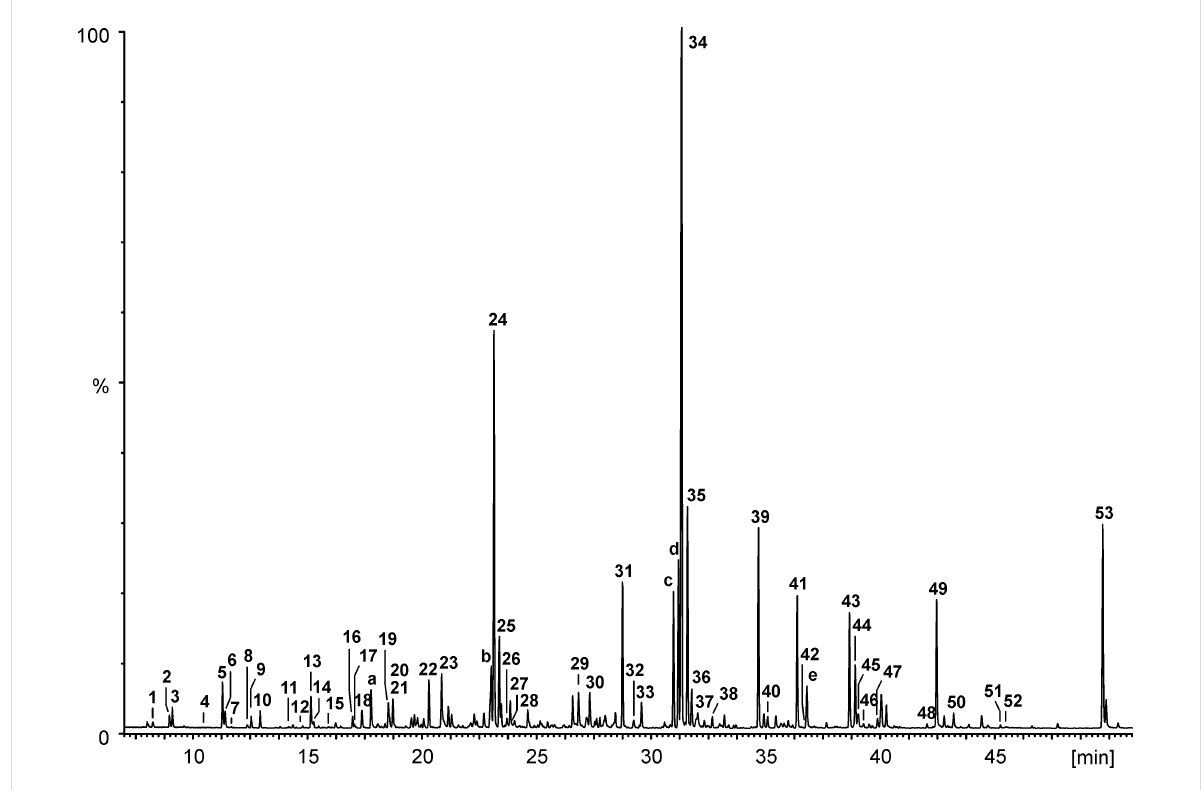
Figure 2: GC/MS-chromatogram (total ion current) of the headspace of X. c. pv. vesicatoria 85-10 grown in 10 L liquid nutrient broth without glucose. Compound labels are the same throughout this